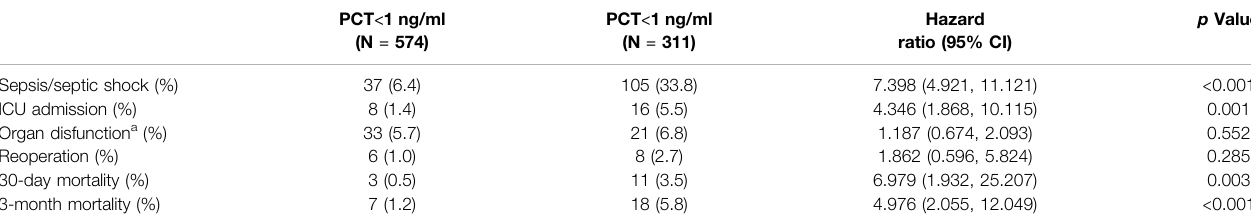
TABLE 4 | Secondaryoutcomes.